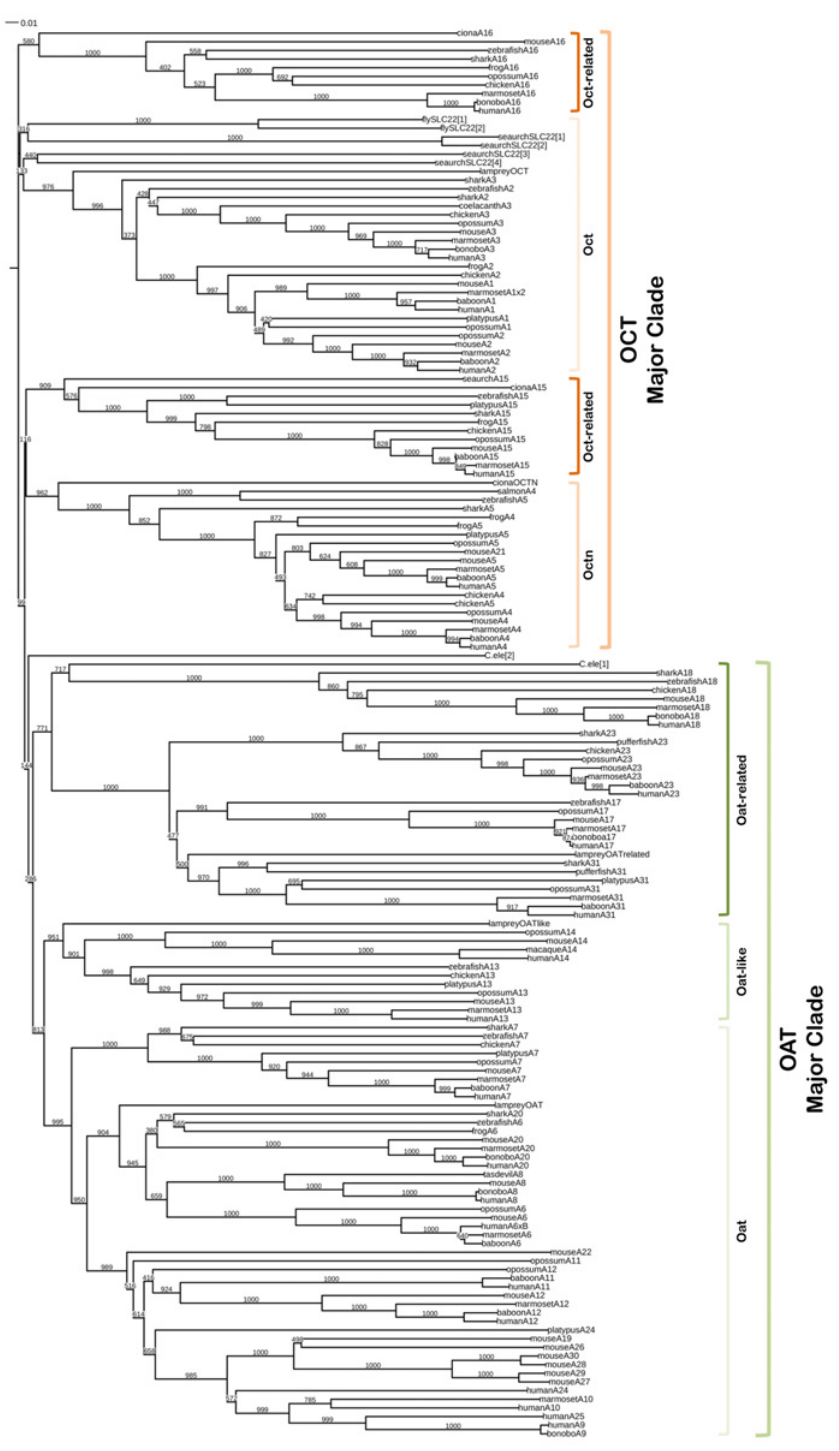
Fig 1. Unrooted Phylogeny of the SLC22 Transporter Family Using 163 Sequences of Various Organisms for Each of the 31 SLC22 Members. The sequences were aligned and the tree was generated using Clustal X 2.1 (using default parameters). The tree was viewed using Interactive Tree of Life (iTOL), an online tree viewing tool [55]. Accession numbers are listed in S1 Table. Bootstrap values are shown at each node of this